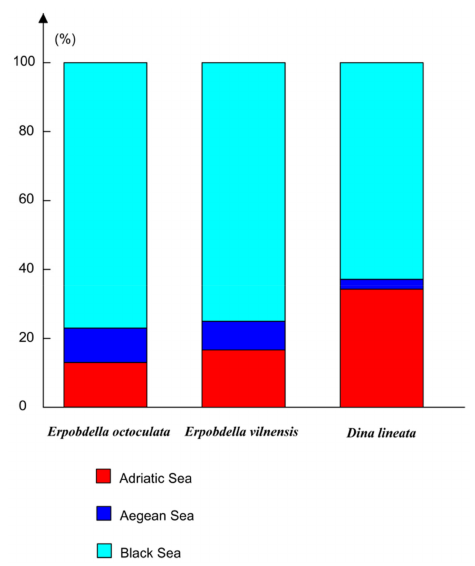
Figure 3. The distribution of the analyzed species in the di ff erent watersheds.